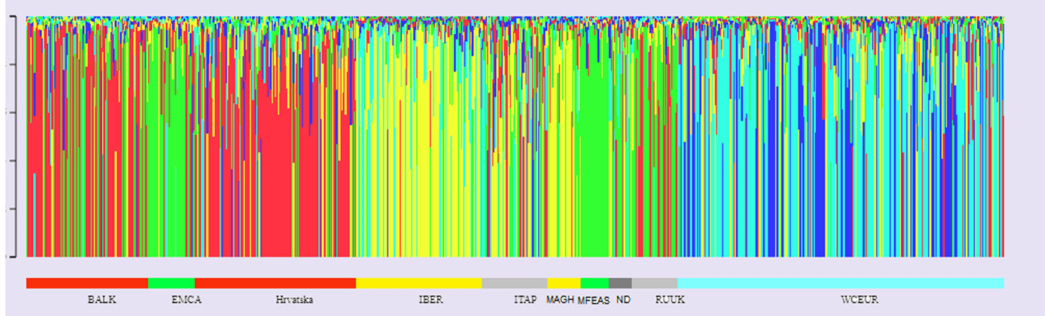
Figure 4. Graphical representation of the proposed structure for k = 5 according to Structure analysis. Each variety is represented by a vertical column colored according to the Q coe ffi cient and the corresponding original population. The following abbreviations represent the sampling regions: BALK = Balkans; EMCA = Eastern Mediterranean and Caucasus; Hrvatska = Croatia; IBER = Iberian Peninsula; ITAP = Apennine Peninsula, MAGH = Maghreb region; MFEAS = Middle East and Far East; ND = a group of undetermined varieties; RUUK = Russia and Ukraine; WCEUR = Western and Central Europe. Balkan ancestral population is marked red, Iber ancestral population is marked yellow, East ancestral population is marked green, Biscay ancestral population is marked light blue, and Gallica ancestral population is marked dark